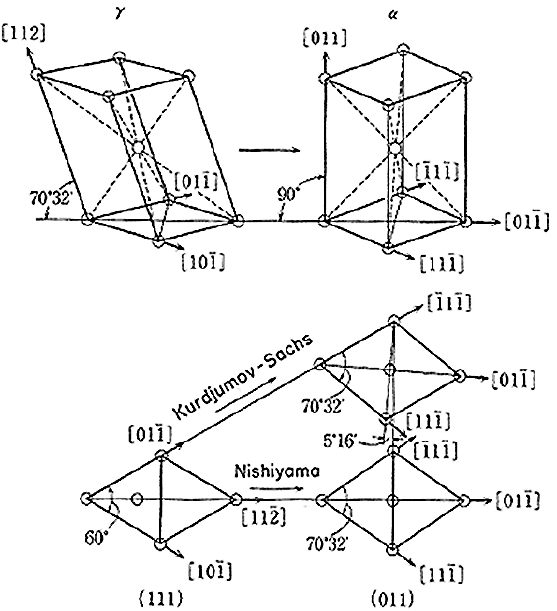
Figure 3. Kurdjumov-Sachs-Nishiyama (KSN) model of face-centered cubic (fcc)–body-centered cubic (bcc) phase transformation proposed by Kurdjumov and Sachs (1930) and Nishiyama (1934). Reprinted from [28] with permission from Elsevier.